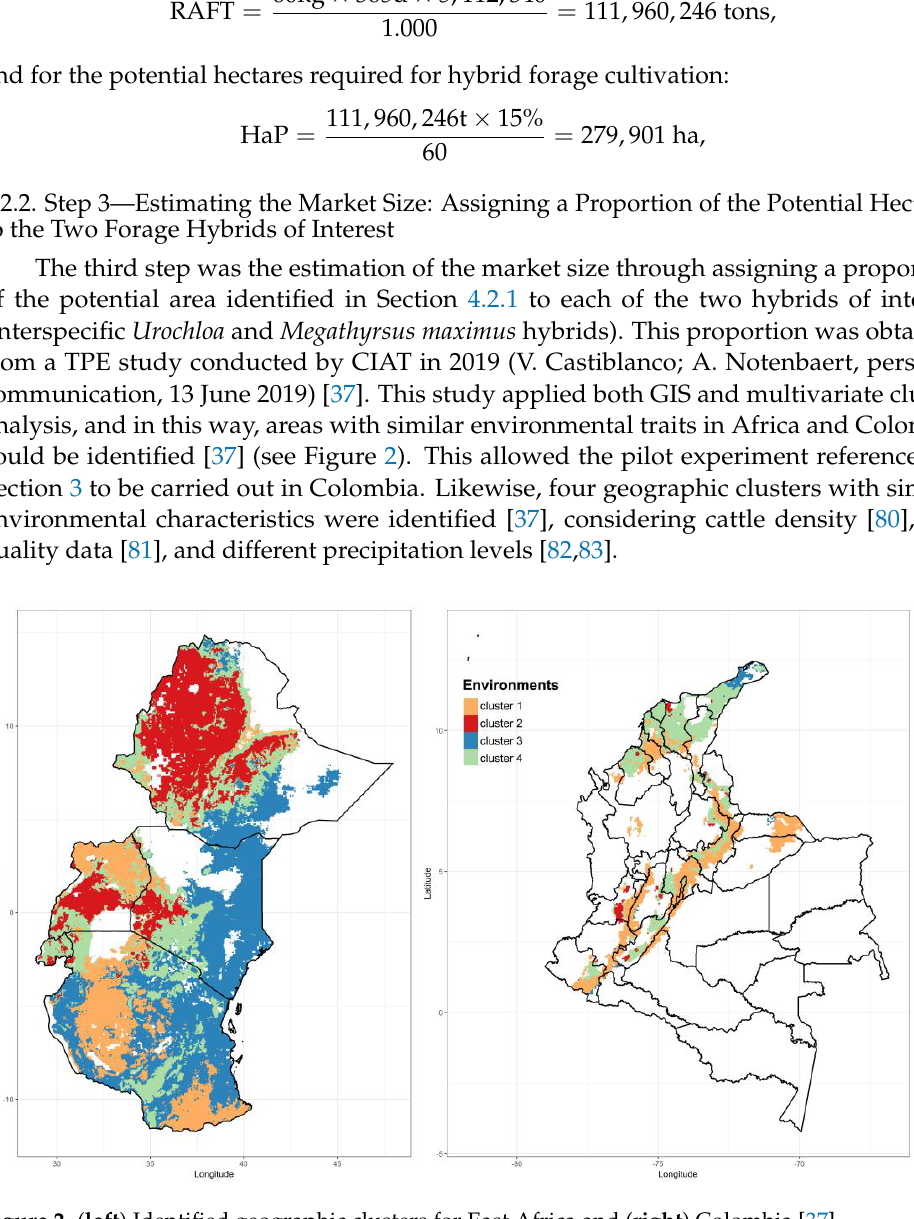
Figure 2. ( left ) Identified geographic clusters for East Africa and ( right ) Colombia [37].